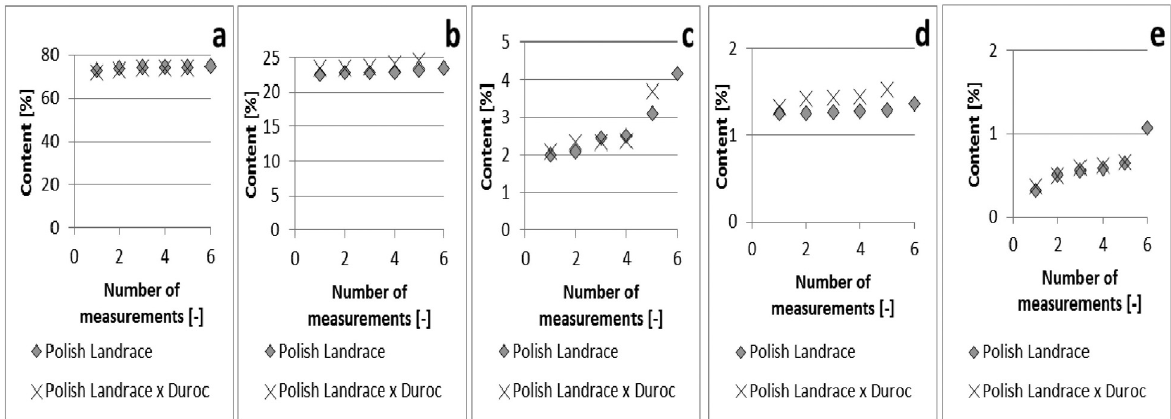
Figure 2 - (a). Water content values [%] for the analyzed 6 cuts of Polish Landrace breed and 5 cuts of Polish Landrace x Duroc crossbreed animals (p<0.1); (b). Protein content values [%] for the analyzed 6 cuts of Polish Landrace breed and 5 cuts of Polish Landrace x Duroc crossbreed animals (p>0.1); (c). Fat content values [%] for the analyzed 6 cuts of Polish Landrace breed and 5 cuts of Polish Landrace x Duroc crossbreed animals (p<0.01); (d). Ash content values [%] for the analyzed 6 cuts of Polish Landrace breed and 5 cuts of Polish Landrace x Duroc crossbreed animals (p<0.05); (e). Collagen content values [%] for the analyzed 6 cuts of Polish Landrace breed and 5 cuts of Polish Landrace x Duroc crossbreed animals